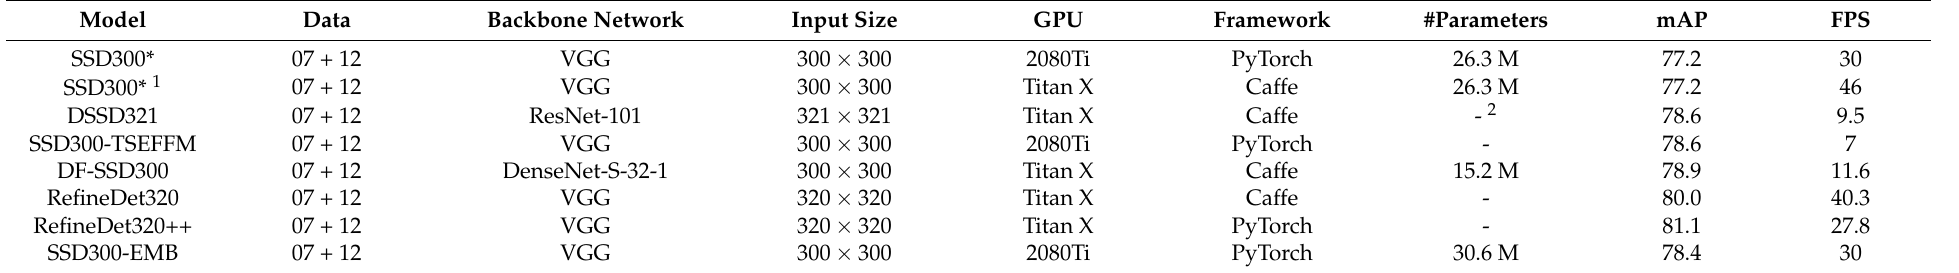
Table 2. Detection results on the PASCAL visual object classes (VOC) 2007 test set (GPU: graphics processing unit, mAP: mean average precision, FPS: frames per second).